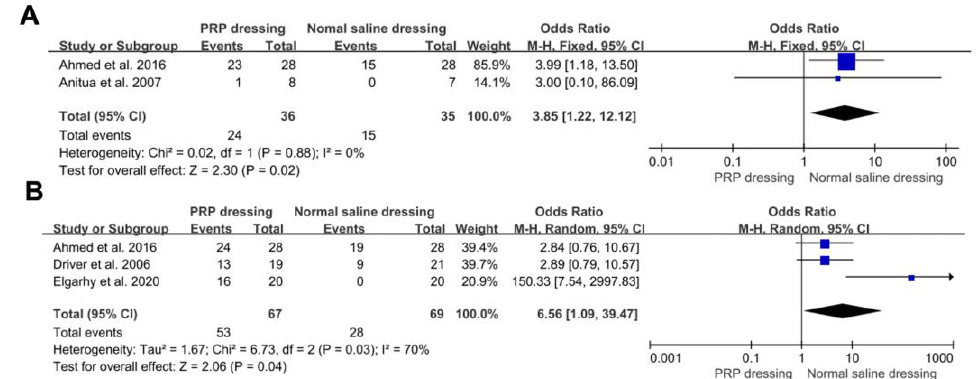
Figure 3. Forest plot showing the healing rates of PRP dressing versus normal saline dressing groups. ( A ) The complete healing rates of PRP and normal saline dressing groups at 8 weeks. The events were the number of complete healing wounds at 8 weeks. ( B ) The complete healing rates of PRP and normal saline dressing groups at 12 weeks. The events were the number of complete healing wounds at 12 weeks.